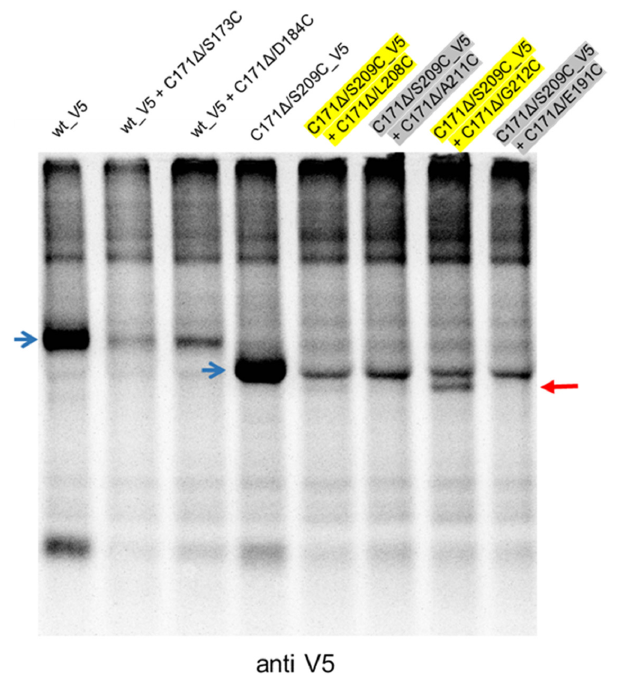
Figure 5. Co-immunoprecipitation experiments of E rns mutants with Cys at different positions. E rns wt_V5 was transiently expressed in cells either alone (utmost left lane) or together with the indicated two E rns mutants containing a deletion of C171 in combination with Cys at position 173 or 184 (second and third lane, respectively). Similarly, the five lanes on the right show the results for E rns mutant C171 ∆ /S209C_V5 alone or in combination with the indicated mutants. For better readability, the complex names of the constructs shown in the right four lanes were highlighted in different colors. Precipitation was done with the anti-V5 serum. Samples were separated via 10% SDS-PAGE under nonreducing conditions. Blue arrows point at E rns homodimers of two monomers containing V5. The red arrow on the right side of the gel labels a heterodimer most likely composed of one monomer with a V5 tag and one monomer without a tag. Because of the complex construct names in the right 4 lanes, yellow and grey shadows are used to make it easier to identify which construct is shown in which lane.